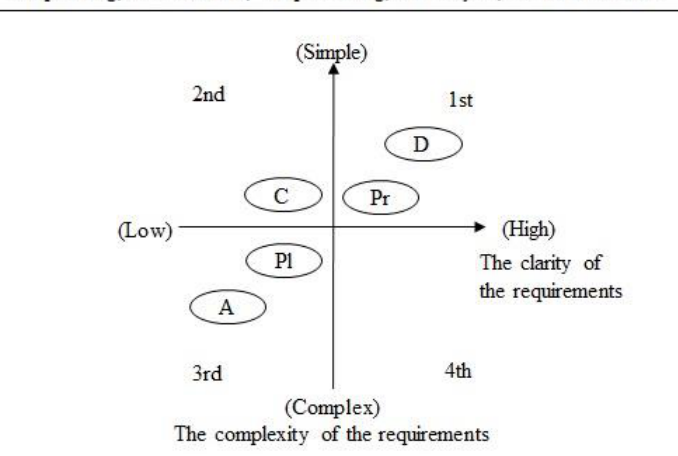
ffi culty of the Figure 3. Difficulty of the requirements. Figure 3. Di